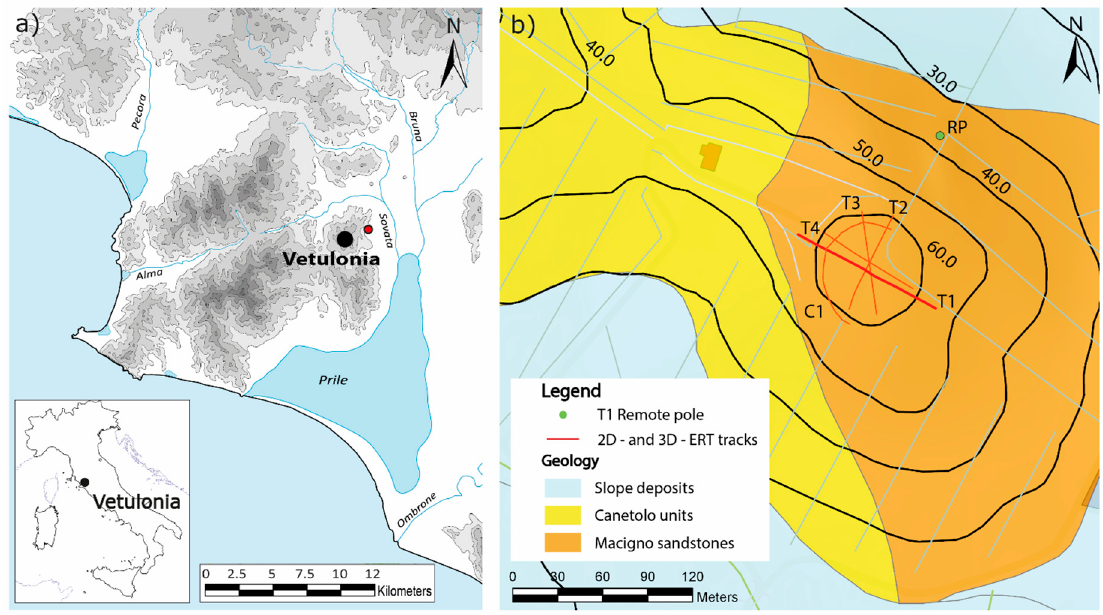
Figure 1. Maps of the study area. ( a ) Ancient map of the Etrurian region around Vetulonia in the 6th century BC, with the location of Poggio Pepe Tumulus (red dot). ( b ) Locations of the 2D-ERT (T1-T4, red lines) and 3D-ERT (C1, C-shaped red line) over the geological map of the study area. Light green dot (RP) represents the remote pole employed in the T1 pole-dipole acquisitions.